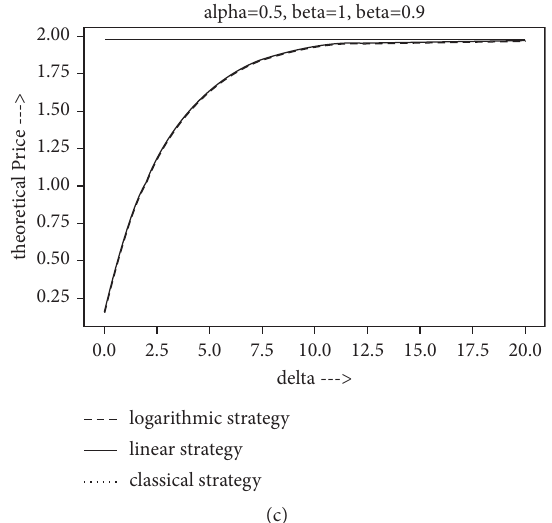
� 0.3, 0.6, or 0.9 (a, b, c), respectively. 0